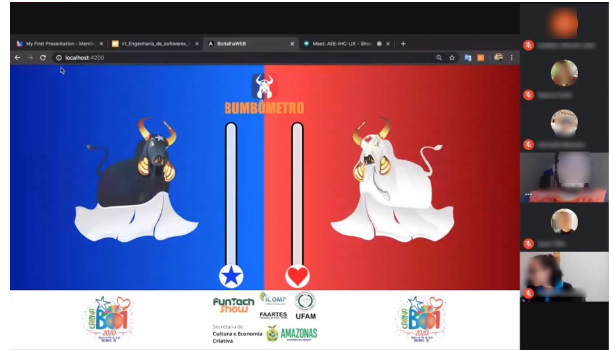
Figure 10. Feedback screen of online interaction using the Bumbometer.